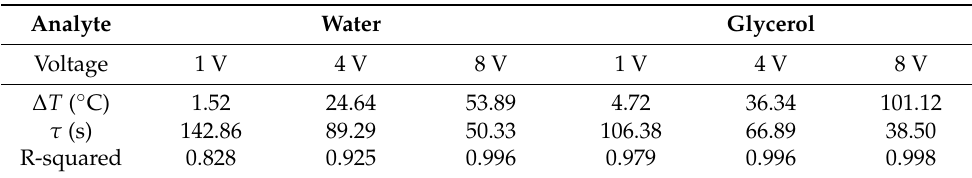
Table 1. The curve-fitted results for the maximum temperature difference ( ∆ T ) and time constant ( τ ) for various applied voltages.